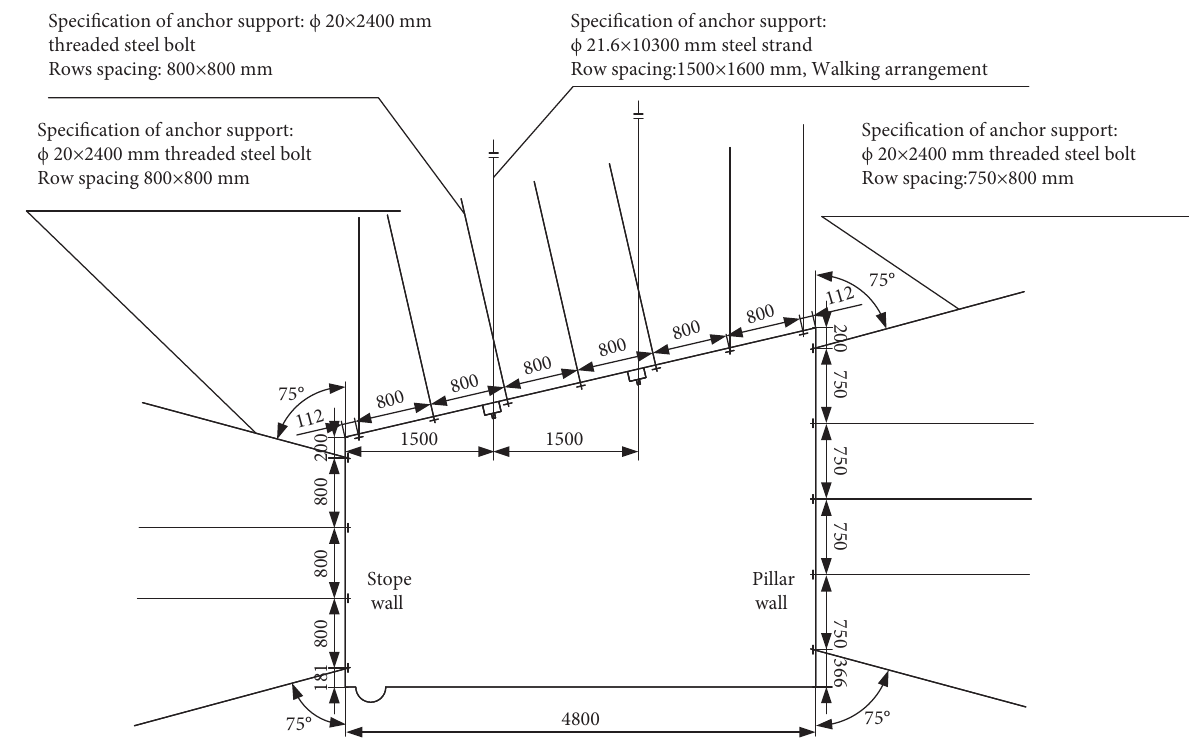
Figure 2: Bolt support drawing of 7135 return air roadway section. Table 1: Experimental mechanical parameters of each rock